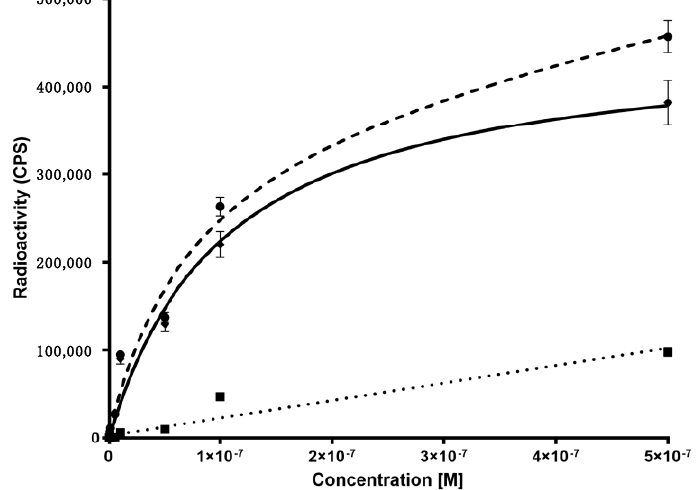
Figure 3. Saturation binding assay of radiolabelled anti- α 4 β 7 integrin mAb showing total binding (dashed line), specific binding (continuous line) and non-specific binding obtained by blocking with 100-fold molar excess unlabelled anti- α 4 β 7 integrin mAb (dotted line) on TK-1 cells.